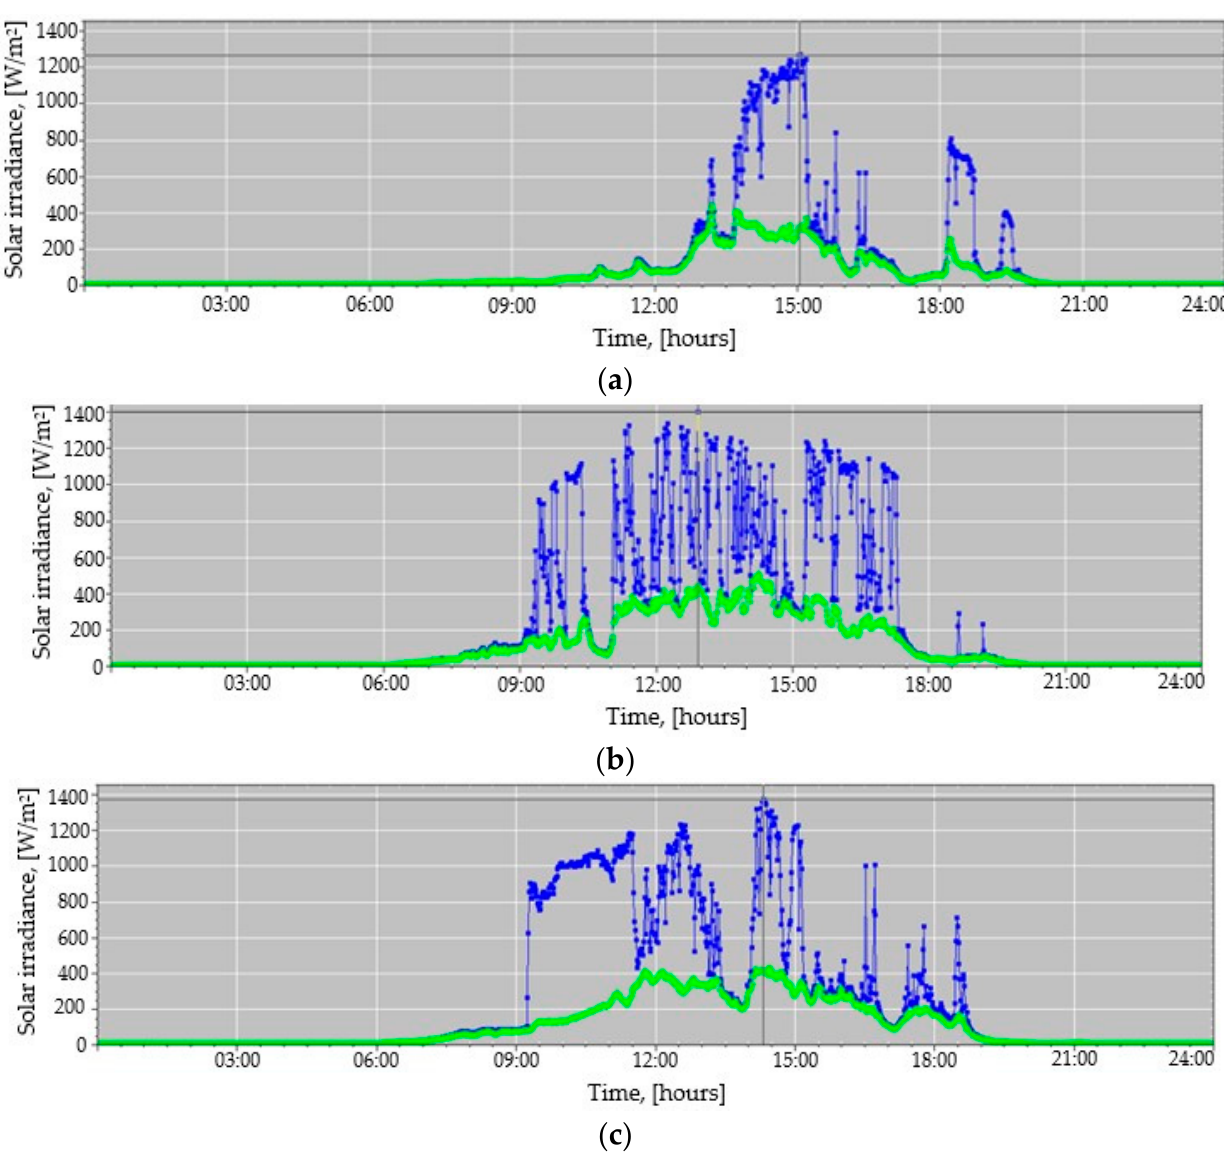
Figure 12. ( a ) Solar irradiance variations for 23 June 2022: ( – total component; – diffuse component). ( b ) Solar irradiance variations for 24 June 2022: ( – total component; – diffuse component). ( c ) Solar irradiance variations for 25 June 2022: ( – total component; – diffuse component).